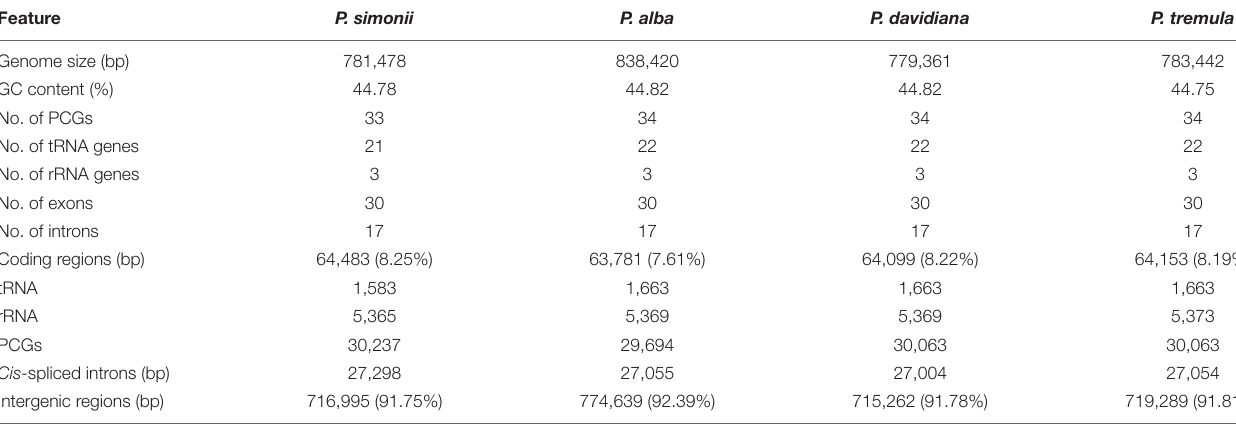
TABLE 2 | General mitogenomic features of four representative plants in the genus Populus .